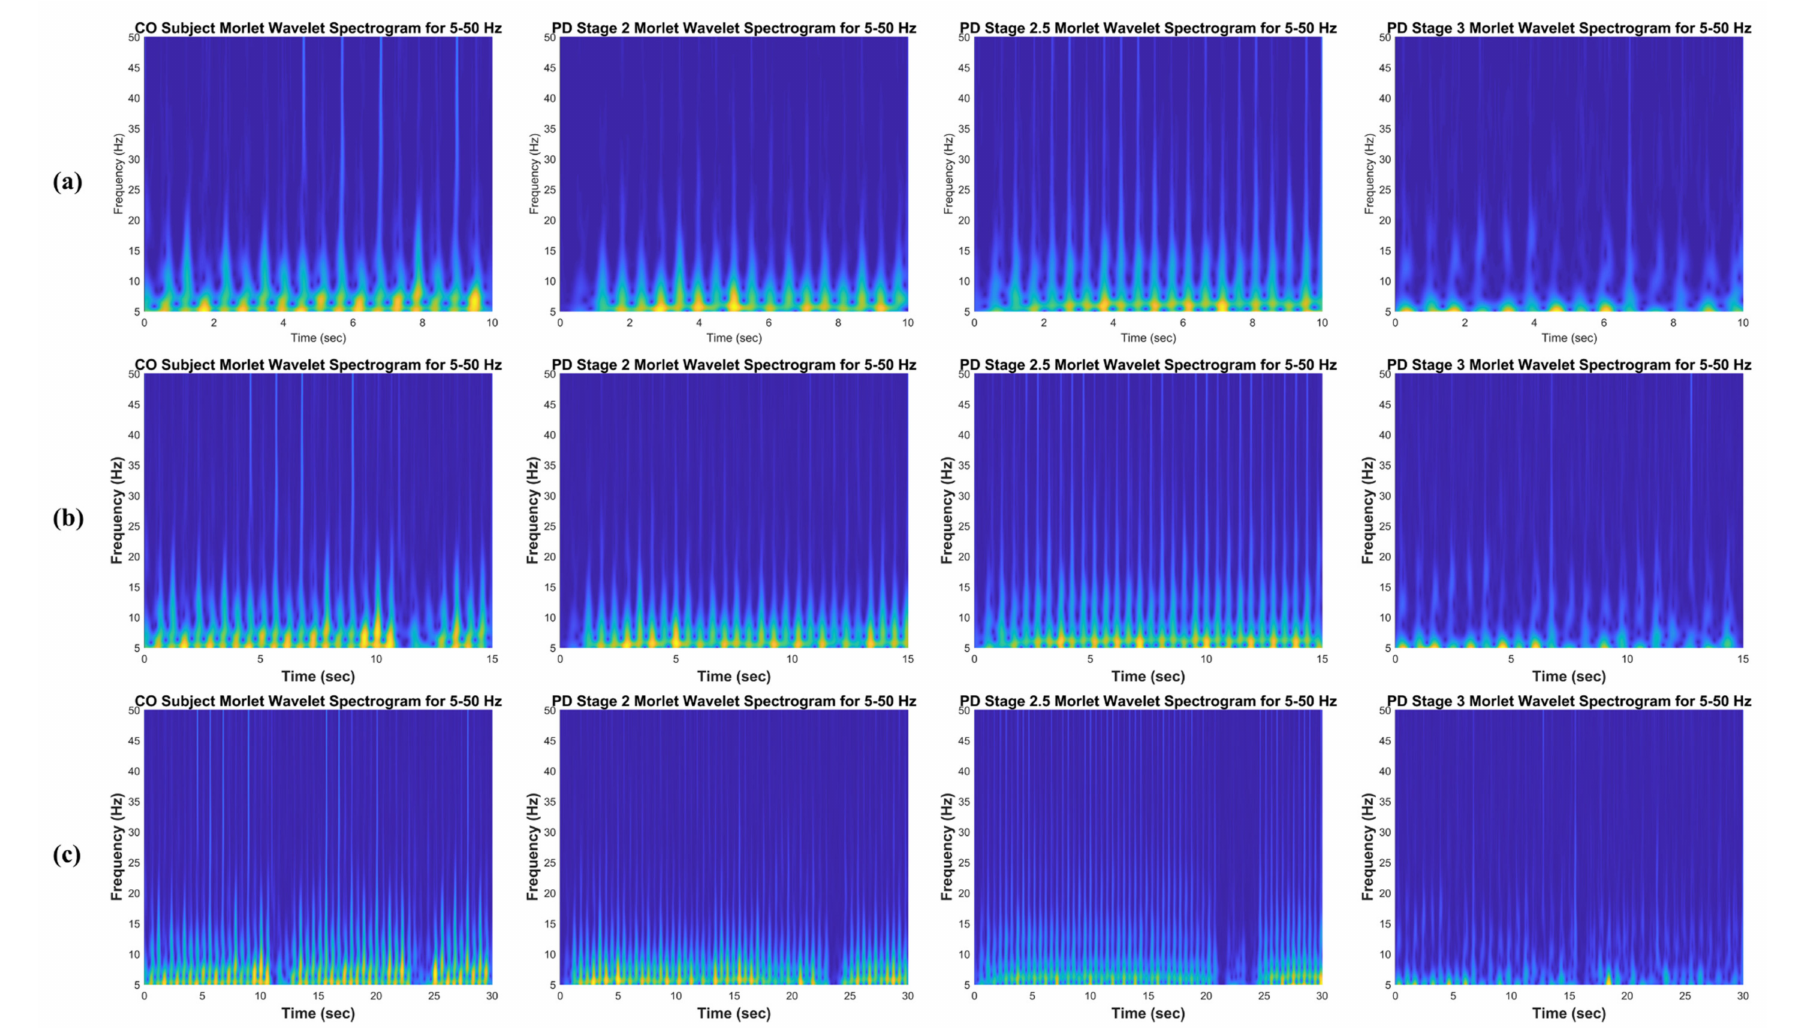
Figure 5. Time-frequency spectrograms using CWT of the CF vGRF signals of CO, PD Stage 2, PD Stage 2.5, and PD Stage 3 subjects in the 5–50 Hz frequency range for ( a ) a 10 s time window size, ( b ) a 15 s time window size, and ( c ) a 30 s time window size from Ga [21]